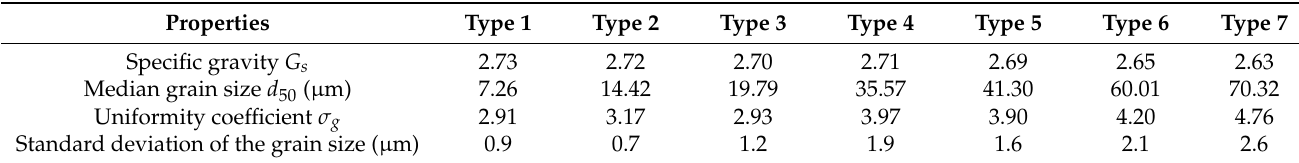
Table 1. Physical properties of the tested silty